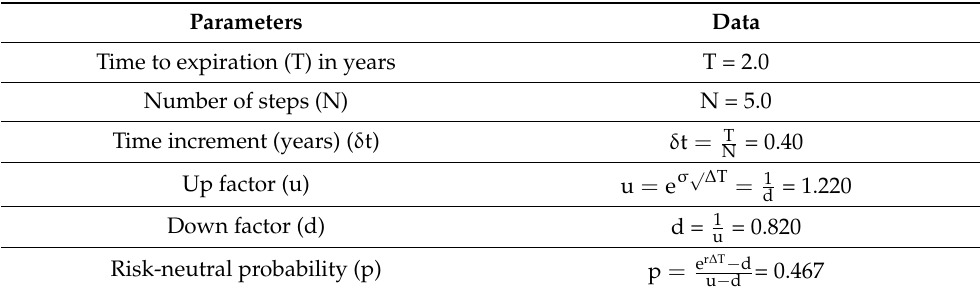
Table 7. Recombining binomial lattice parameters.